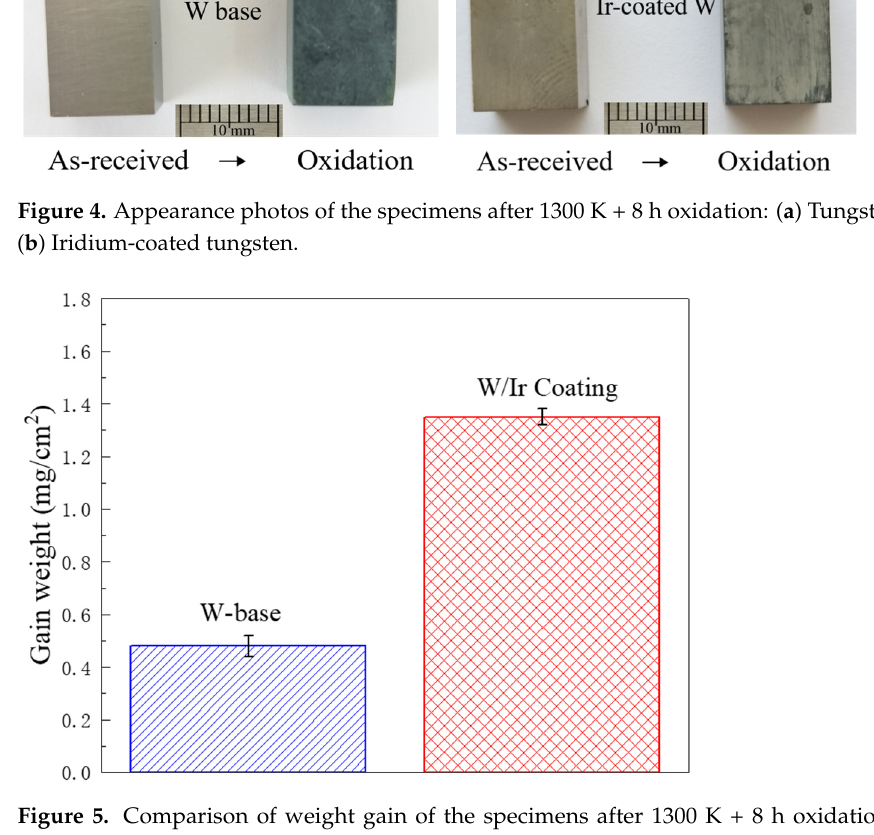
Figure 5. Comparison of weight gain of the specimens after 1300 K + 8 h oxidation: Tungsten substrate, Iridium-coated tungsten.